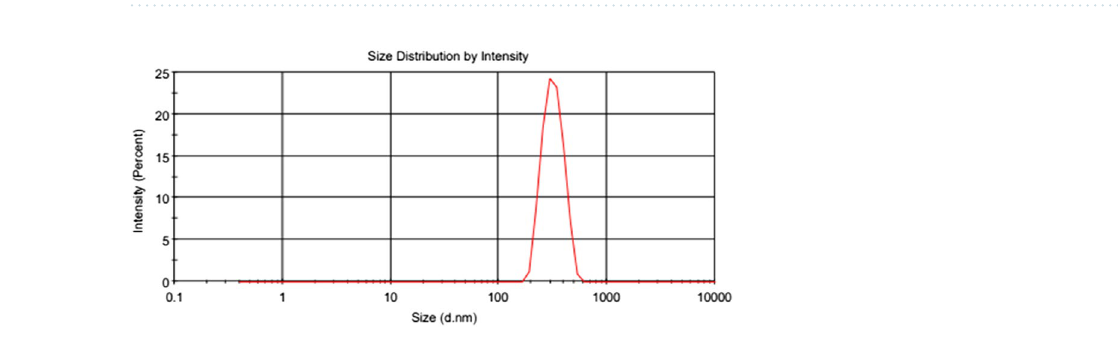
Figure 6. DLS images of the TiO 2 nanoparticles.